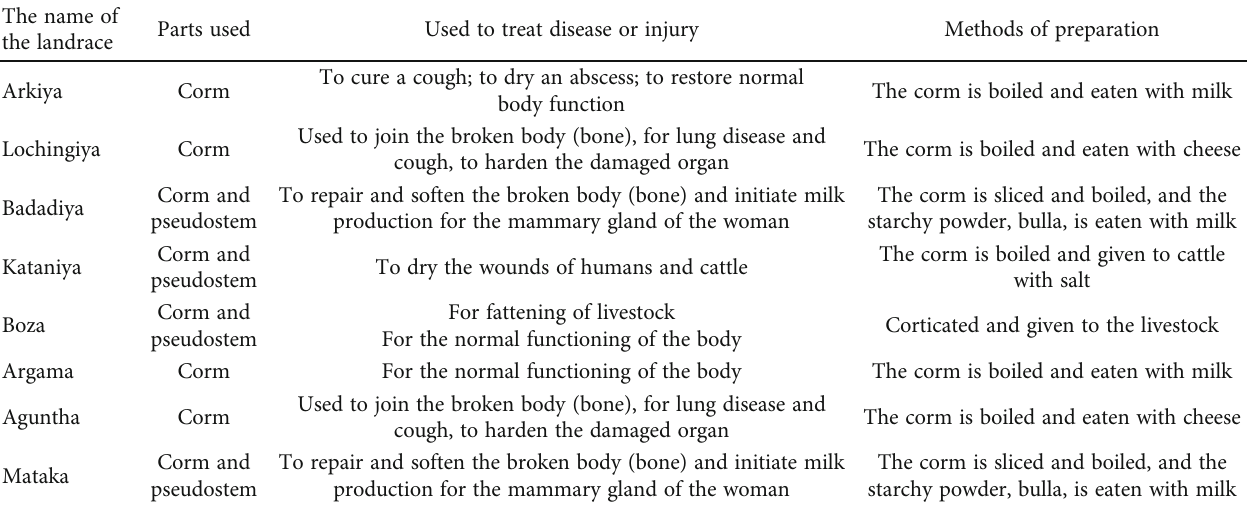
Table 8: Enset landraces, part/s used for treatment, disease type, medicinal use, and preparation